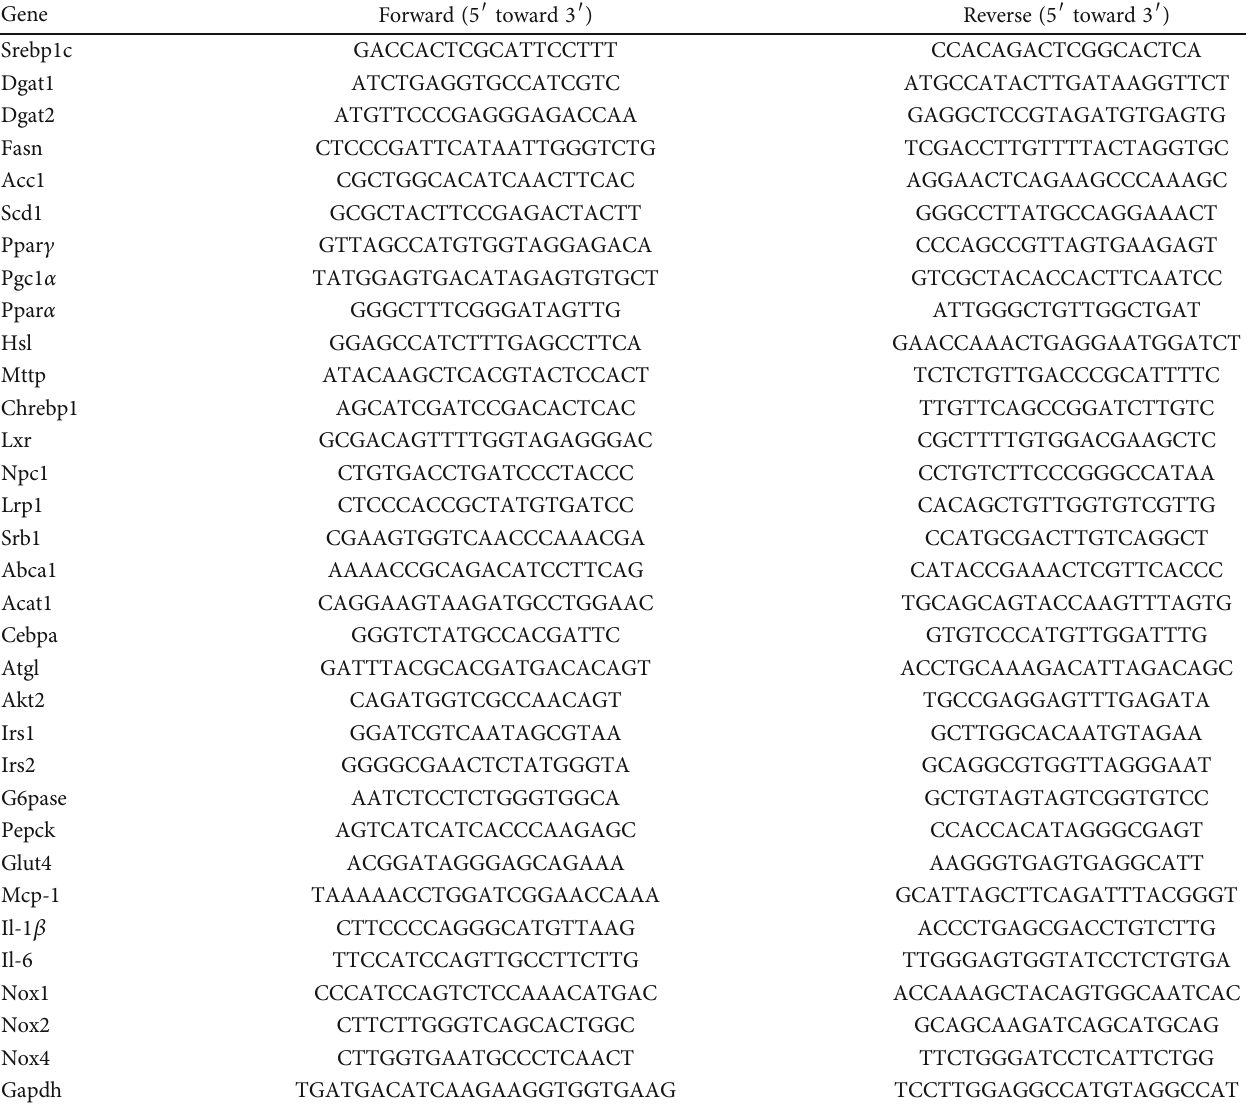
Table 1: Primer sequences used in the